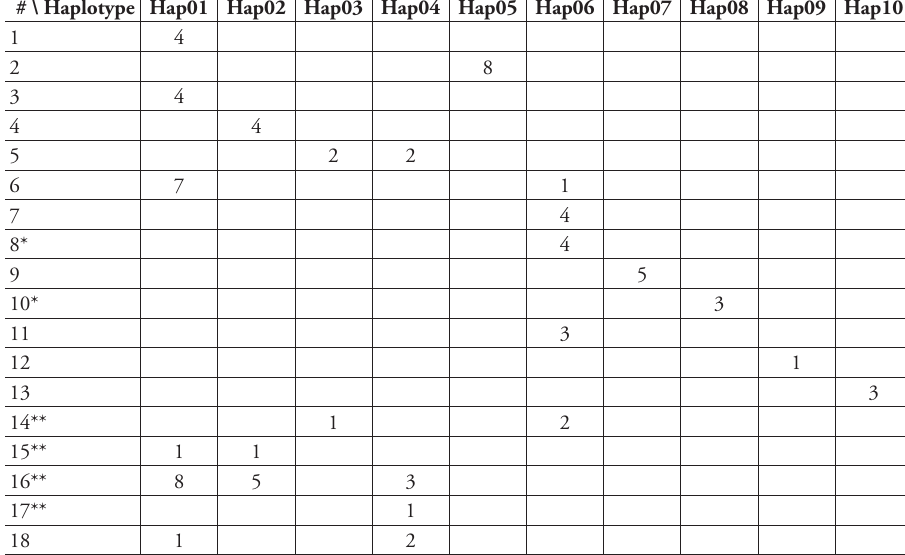
Table 2. Haplotype composition of